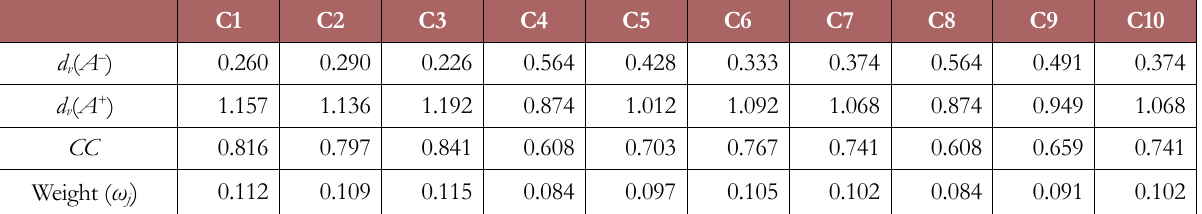
Table 21. Weight of